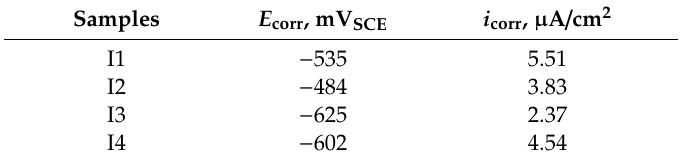
Table 3. E corr and i corr values from the cyclic potentiodinamic polarization (CPP) curves of each